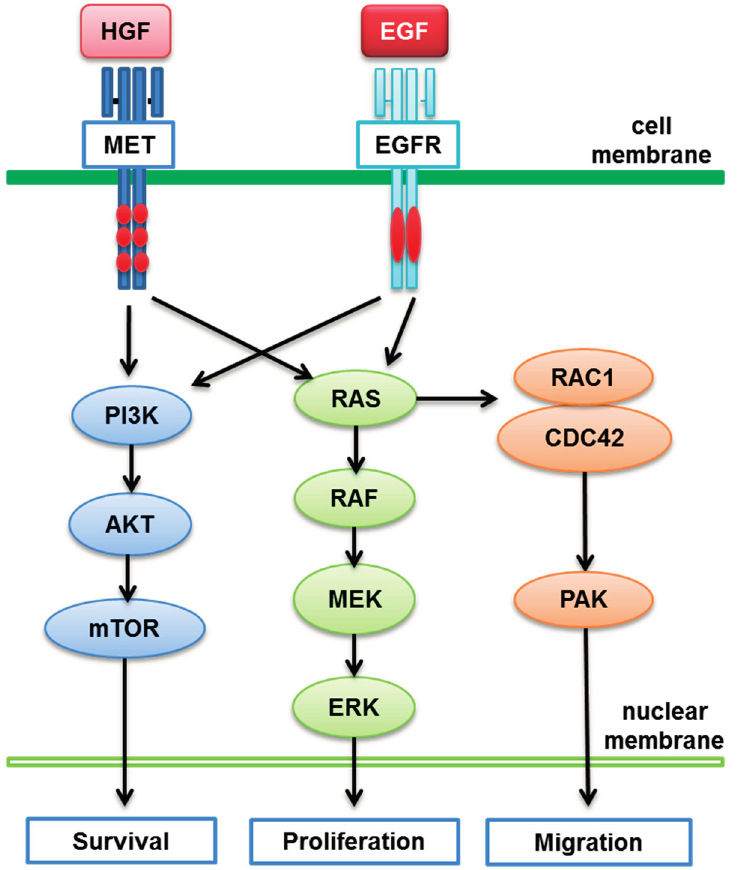
Figure 2. Crosstalk between the MET and EGFR pathways. HGF: hepatocyte growth factor; EGF: epidermal growth